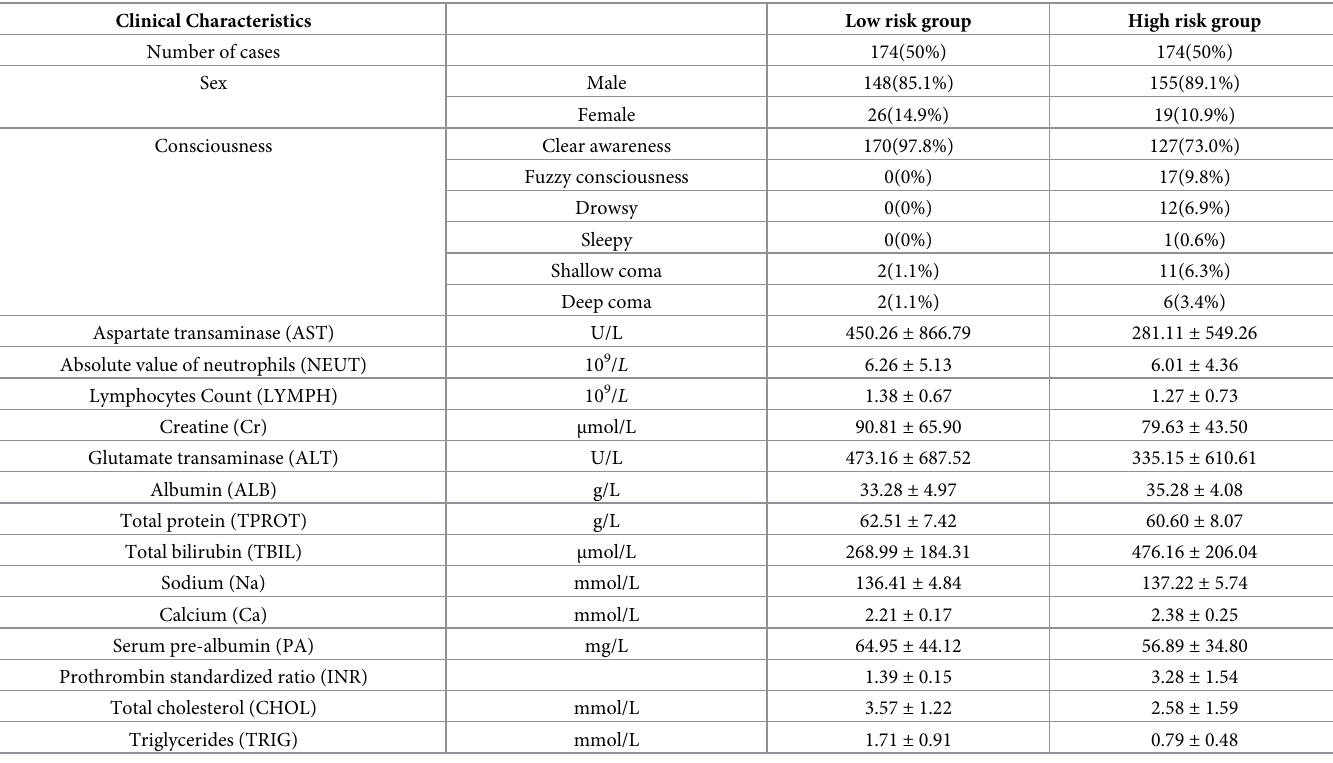
Table 1. Comparison of clinical characteristics between high risk and low risk groups in patients with LF. Clinical